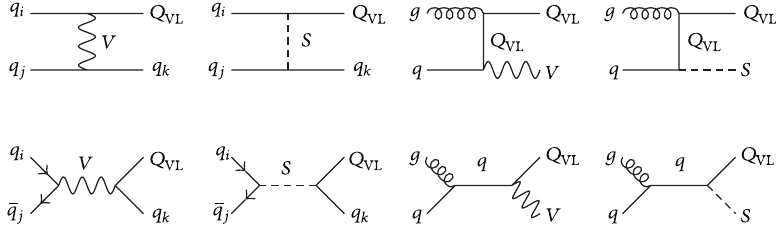
Figure 6: Feynman diagrams for single production of a generic VLQ. VLQs can interact with SM quarks both through charged currents and neutral currents, allowing FCNCs also within SM states in diagrams with 𝑞 𝑖 − 𝑞 𝑗 − {𝑉,𝑆} interactions. Arrows on fermion lines have been removed to account for both particles and antiparticles, when necessary. Notice that not all diagrams are allowed for a specific VL quark (e.g., neutral currents are not allowed for quarks with exotic electric